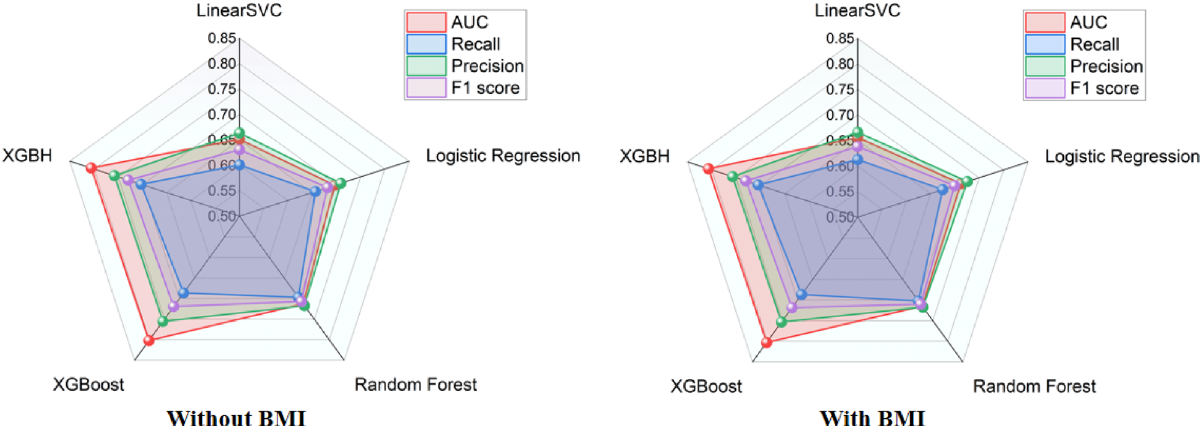
Figure 1. Performance of all prediction models under various